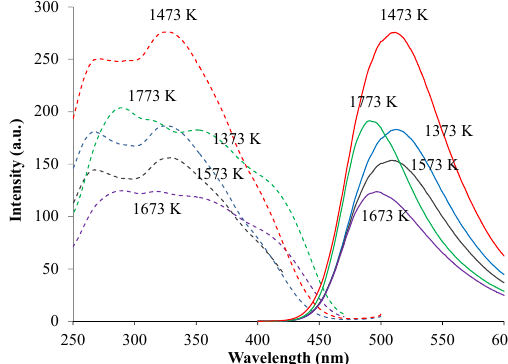
Figure 5. Relationship between photoluminescence (PL) intensity and annealing temperature in (Ca 1.95 Eu 2+ 0.02 (cid:3) 0.03 )(Si 0.94 P 0.06 )O 4 Table 1. Emission and excitation wavelengths of (Ca 1.95 Eu 2+0.02 □ 0.03 )(Si 0.94 P 0.06 )O 4 phosphors. Annealing Temperature (K) λ ex (nm)